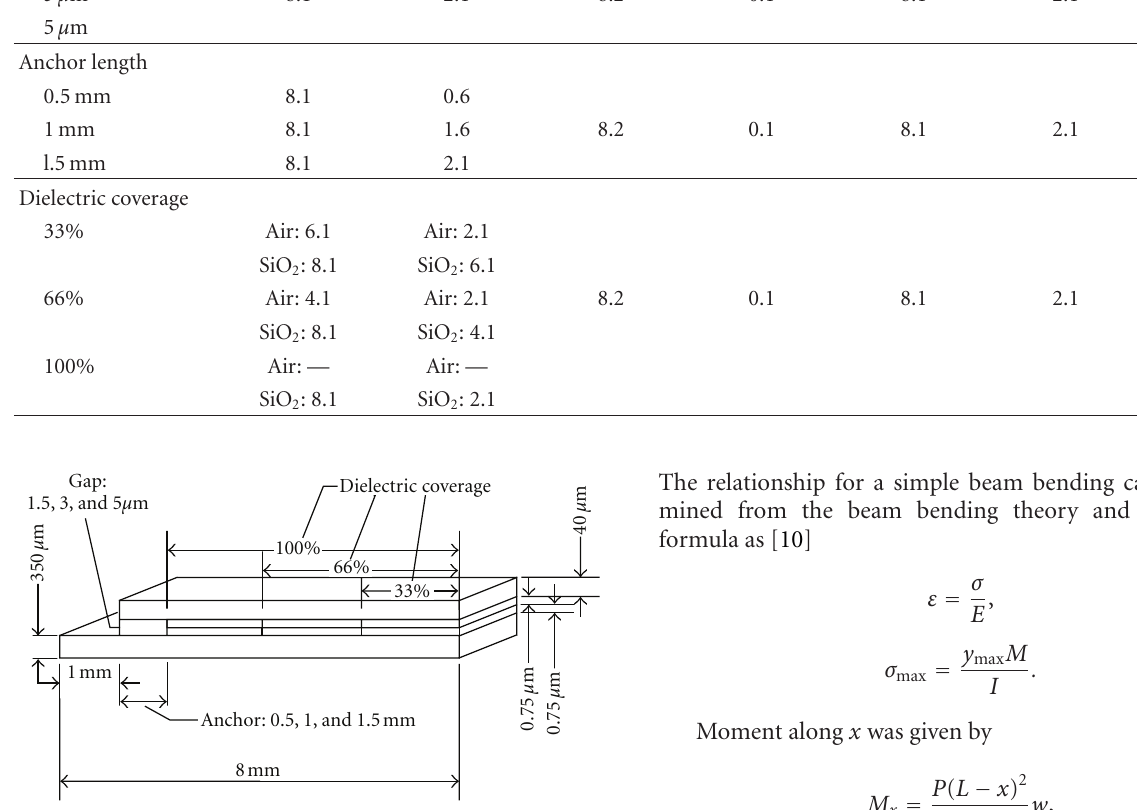
Figure 1: Schematic diagram of the sensor with three parameters for sensitivity enhancement.